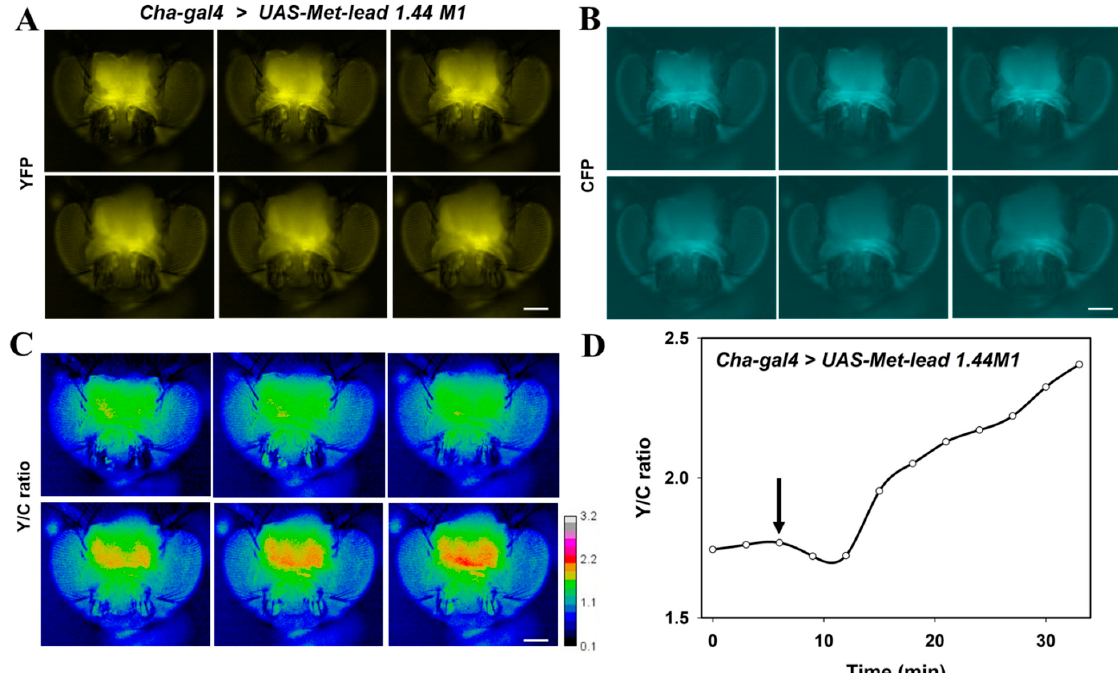
Figure 4. In vivo Pb biosensing in the adult brain of Drosophila (strain Cha-gal4 > UAS-Met-lead 1.44 M1) using FRET ratio live imaging. ( A – C ), Representative fluorescence images of YFP ( A ) and CFP ( B ) emission, and the Y/C ratio (YFP/CFP, ( C )), in the fly brain during a 35-min recording. The color bar in C represents ratio values from 0.1 to 3.2. The scale bars are 100 μ m. ( D ), Time-lapse changes in the Y/C ratio value (YFP/CFP) during the in vivo recording. Pb (10 μ M) was introduced at the time point indicated by arrows until the end of the recording.